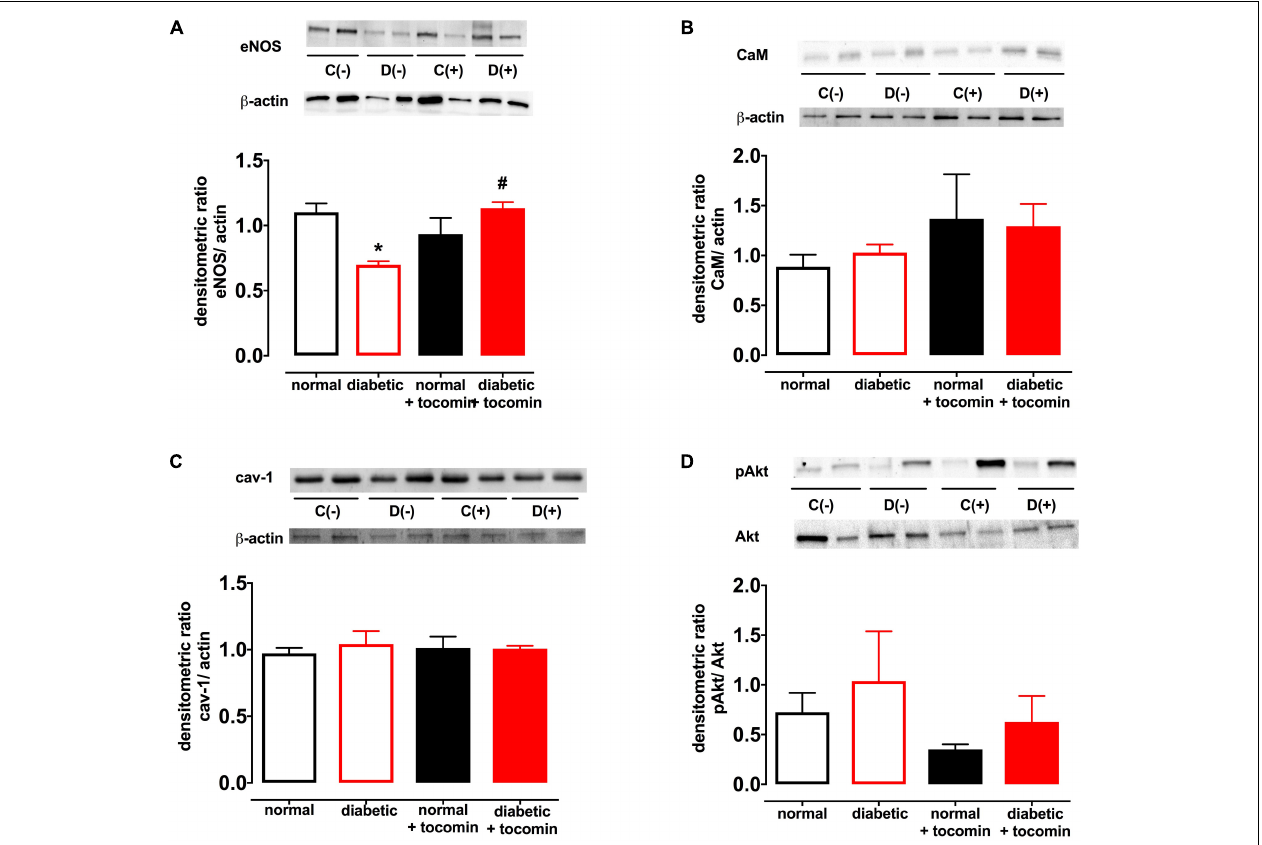
FIGURE 5 | Protein expression of total eNOS (A) , calmodulin-1 (B) , caveolin-1 (C) , and pAkt/Akt (D) from isolated aortae from normal, diabetic, and tocomin treated (normal + tocomin/diabetic + tocomin) rats. Representative blots are shown for each corresponding graph. ∗ Significantly different to normal. # Significantly different to diabetic. Results are shown as means ± SEM; p < 0.05. Two-way ANOVA Dunnett’s multiple comparisons test. n = 3–5